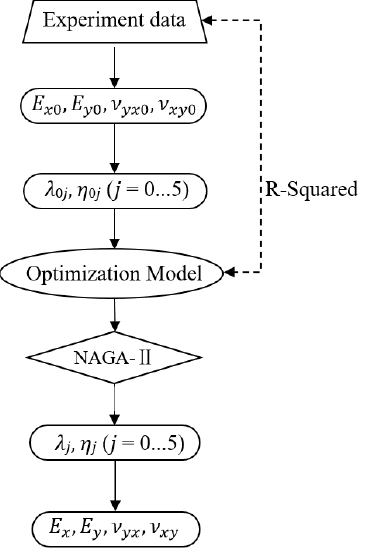
Figure 2. Optimal process.